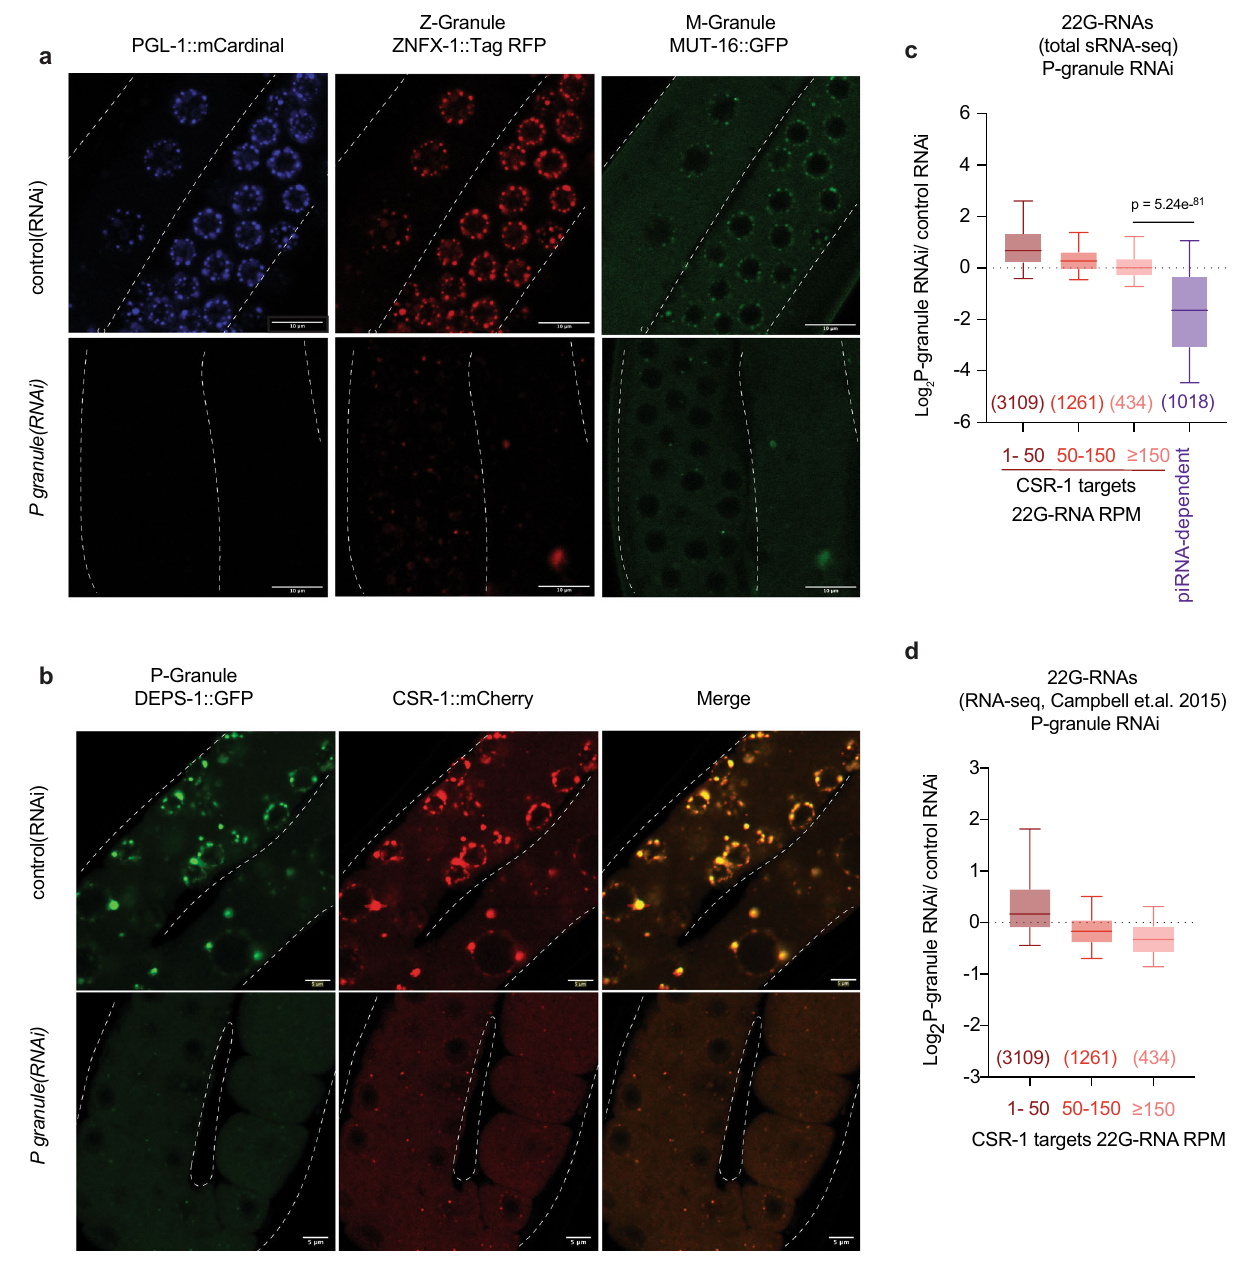
Fig. 3 Biogenesis of CSR-1 22G-RNAs and the regulation of their targets do not require germ granule localization. a Live- fl uorescent images of animals expressing P granule marker PGL-1::mCardinal (P granule), ZNFX-1::TagRFP (Z granule), and MUT-16::GFP (Mutator foci) treated with either control RNAi or P granule RNAi ( pgl-1, pgl-3, glh-1 , and glh-4) . All three granule types are depleted. Scale bars represent 10 µ m. b Live- fl uorescent image of animals expressing P granule marker DEPS-1::GFP (P granule) and mCherry::CSR-1 treated with either control RNAi or P granule RNAi ( pgl-1, pgl-3, glh-1 , and glh-4) . Scale bars represent 5 µ m. CSR-1 is localized in both cytosol and P granule, and upon RNAi treatment, P granule localization of CSR-1 is lost while maintaining cytosolic localization. At least ten individual germlines were imaged for each condition in a , b . c Box plots showing the log 2 fold-change of total 22G-RNA (sRNA-seq) upon P granule RNAi compared to control RNAi. The distribution for the 22G-RNA in CSR-1 IP for CSR-1 targets with 1 – 50 RPM, 50 – 150 RPM, or ≥ 150 RPM (gene list in Supplementary Data 1) and piRNA-dependent 22G-RNA target genes 66 are shown. Data is average of two biological replicates. d Box plots showing the log 2 fold-change of mRNA expression (RNA-seq from Campbell et. al. 41 ) upon P granule RNAi compared to control RNAi. The distribution for the 22G-RNA in CSR-1 IP for CSR-1 targets with 1 – 50 RPM, 50 – 150 RPM, or ≥ 150 RPM. For both the box plots, the line indicates the median value, the box indicates the fi rst and third quartiles, and the whiskers indicate the 5th and 95th percentiles, excluding outliers. Two-tailed P -values were calculated using Mann – Whitney – Wilcoxon tests. The sample size n (genes) is indicated in parentheses. Source data are provided as a Source Data fi optimal and non-optimal codons using our experimental data enrichment in genes with high TE (log 2 TE ≥ 3) were considered from Late L4-staged worms. First, we calculated the normalized optimal codons, and the ones under-represented were considered average relative synonymous codon usage (RSCU) for genes for non-optimal codons (Fig. 5b). We con fi rmed that our classi fi ca- different categories of high or low TE (Fig. 5b). Codons showing tion of optimal/non-optimal codons correlated with tRNA copy